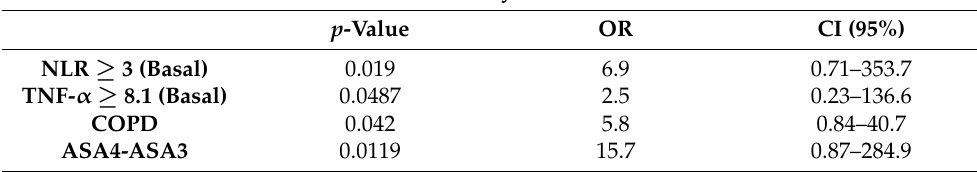
Table 7. Plasma and clinical predictors of mortality in the GHAS trial. COPD: Chronic Obstructive Pulmonary Disease; ASA: The American Society of Anesthesiologists (ASA) class is a system for assessing the risk of patients before surgery. ASA 3 and 4 include patients in poor (ASA 3) and extremely poor (ASA 4) physical condition for surgery. CI: Confidence Interval. ( p < 0.05 is considered to be significant).